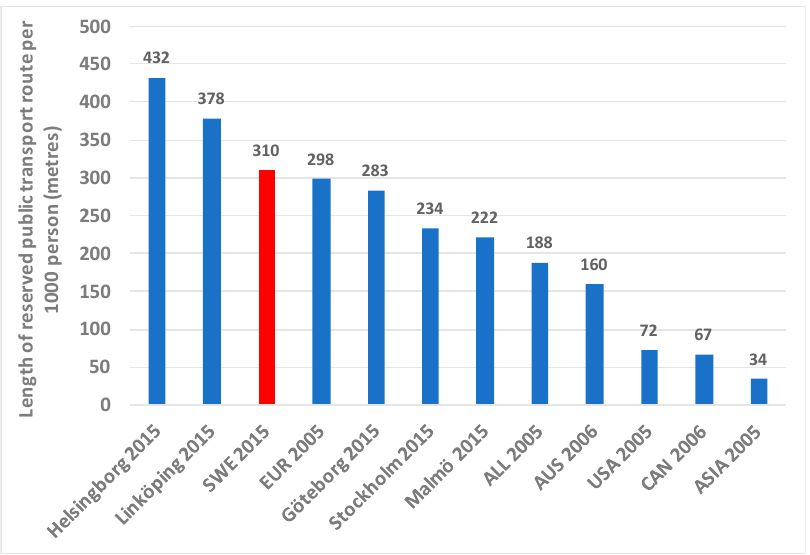
Figure 7. Reserved public transport route per person in five Swedish cities (2015) compared to a sample of global cities (2005–2006).